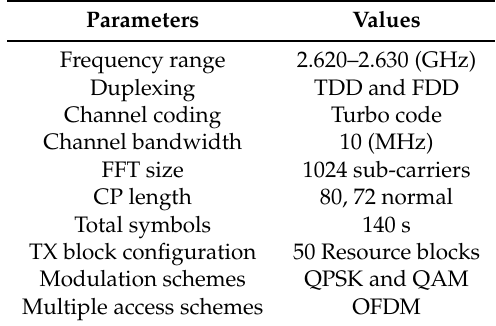
Table 1. Parameters for